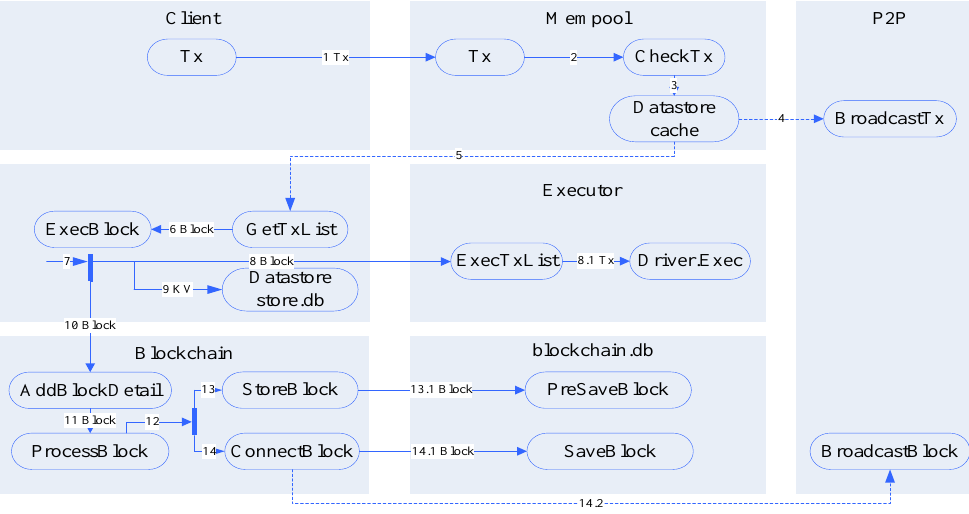
Figure 4. Execution of the smart contract module based on blockchain.